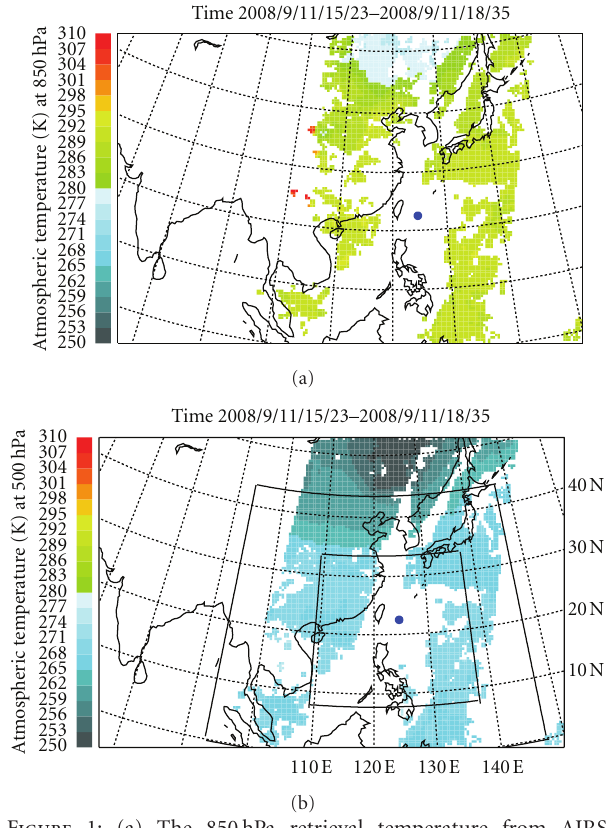
Figure 1: (a) The 850hPa retrieval temperature from AIRS observation within the 3 hours time window for data assimilation for the runs initialized at 1800 UTC, 11 September 2008. Blue filled circle is the center of typhoon. (b) is same as (a) but for temperature at 500hPa. The nested domains for WRF model simulations are superimposed in panel